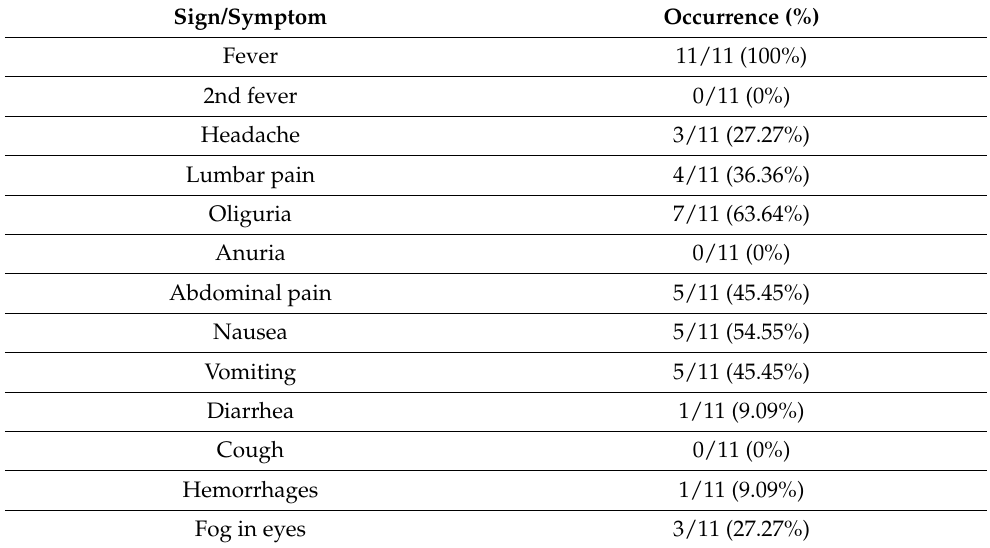
Table 3. Clinical signs and symptoms in pediatric NE patients.